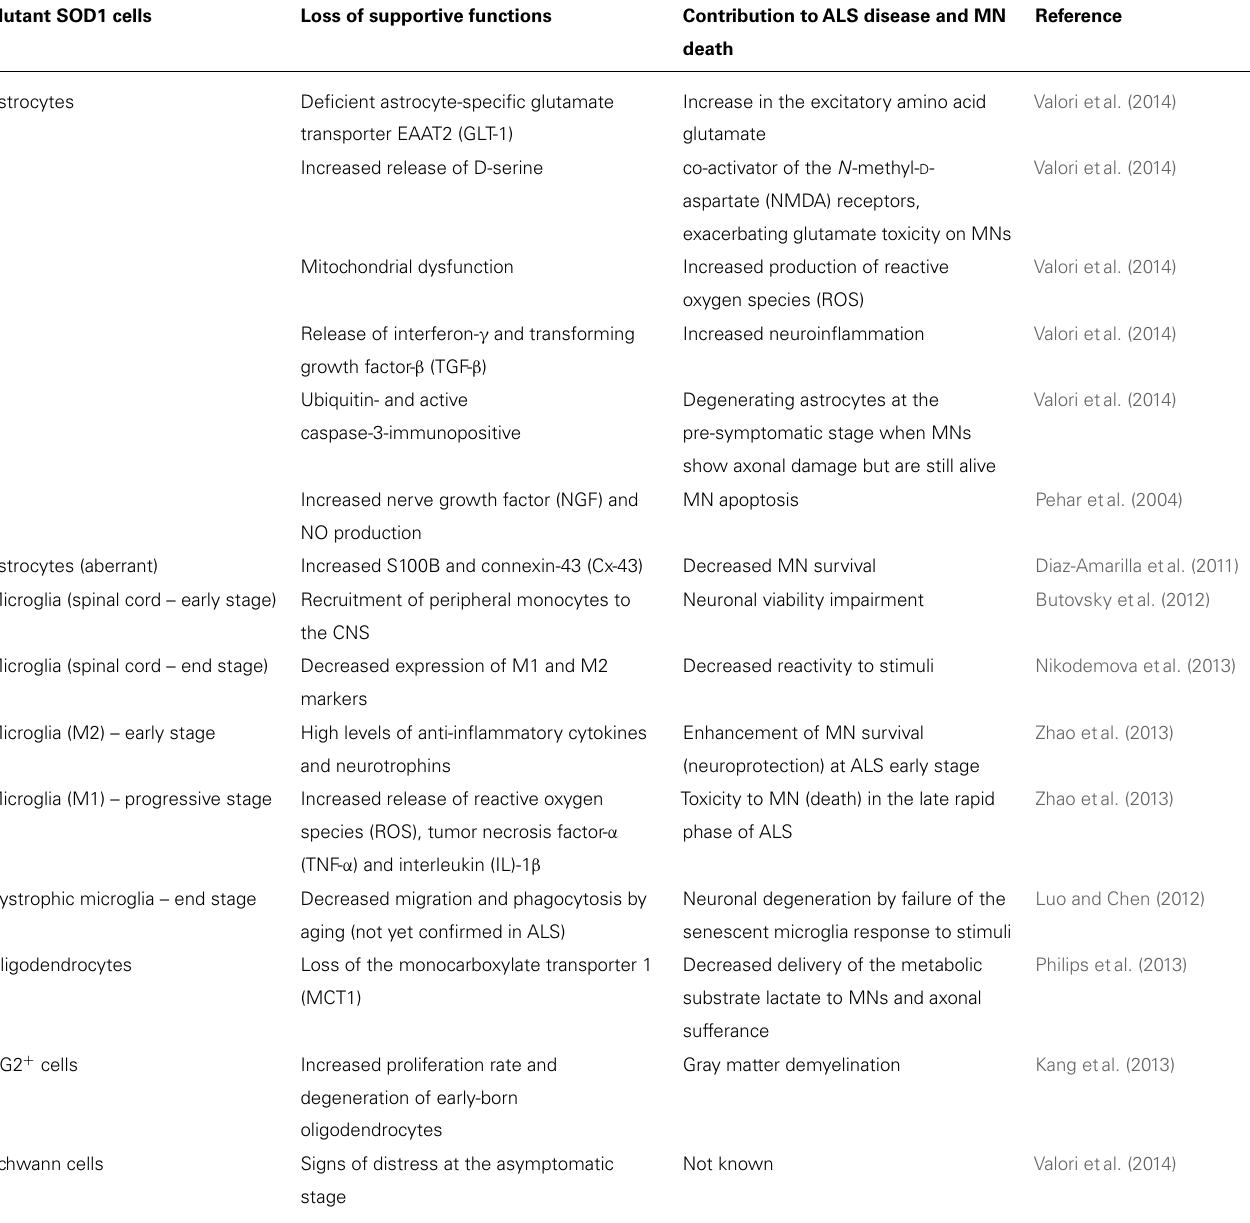
Table 2 | Glial impairment and deregulated glia–motor neuron (MN) interconnectivity in amyotrophic lateral sclerosis (ALS). Mutant SOD1